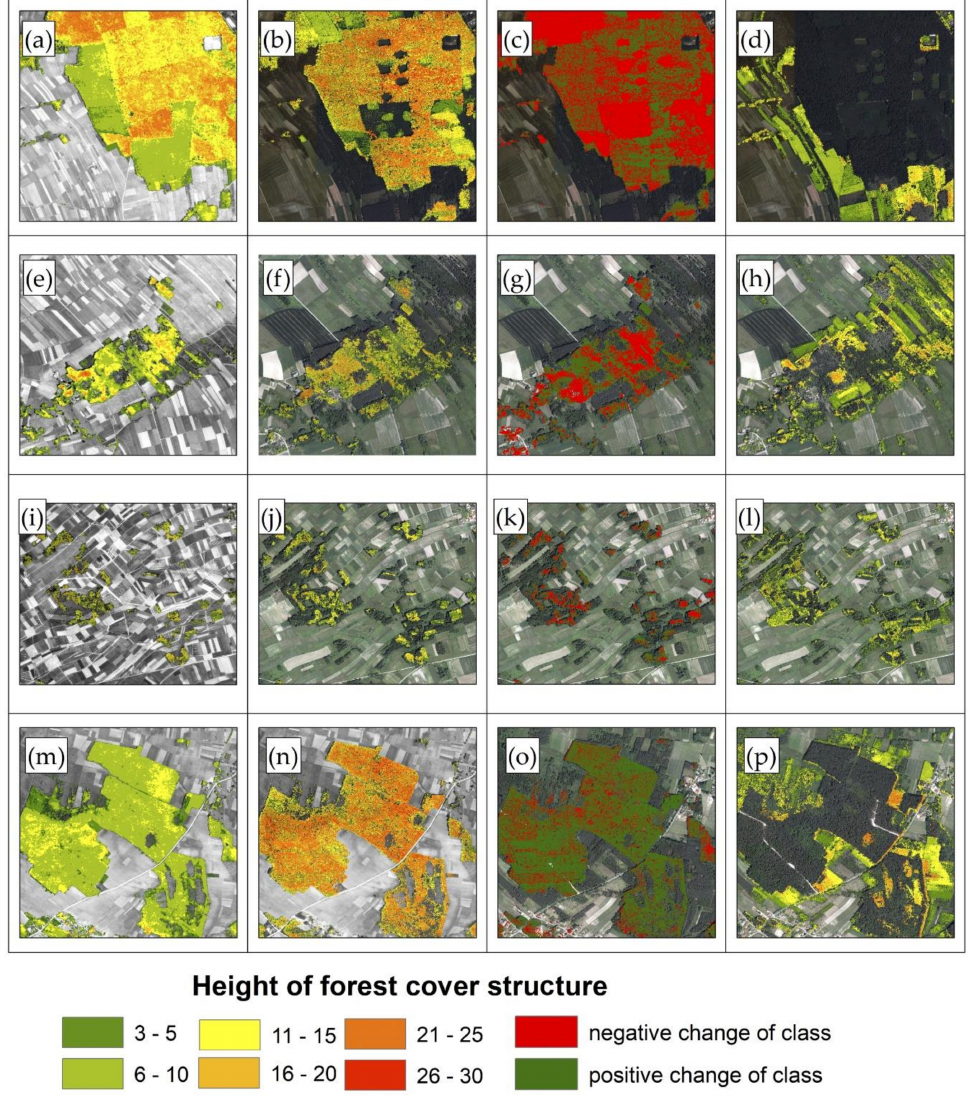
Figure 4. Comparison of height classes for four plots (Plot 1 ( a – d ), Plot 2 ( e – h ), Plot 3 ( i – l ), Plot 4 ( m – p ) developed with the use of archival aerial photographs and light detection and ranging (LiDAR)